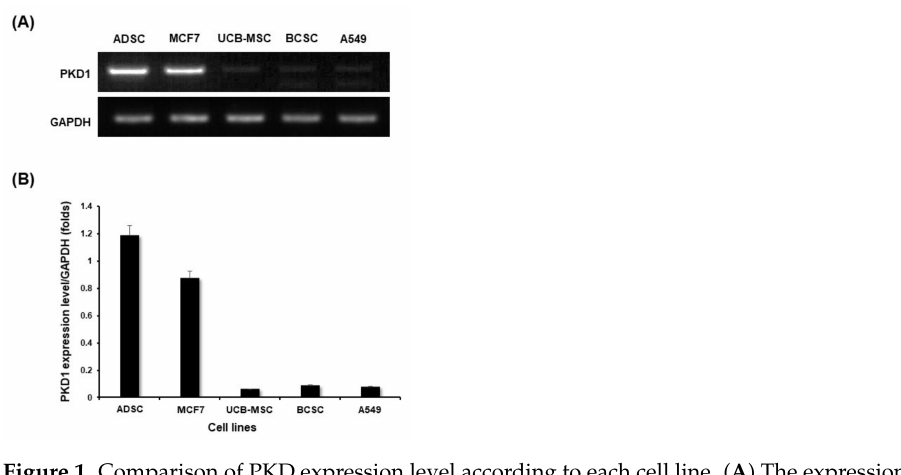
Figure 1. Comparison of PKD expression level according to each cell line. ( A ) The expression level of the PKD1 gene was confirmed by RT-PCR using mRNA extracted from each cell in the transcript level; ( B ) Quantitative values of PKD1 expression were normalized by GAPDH.